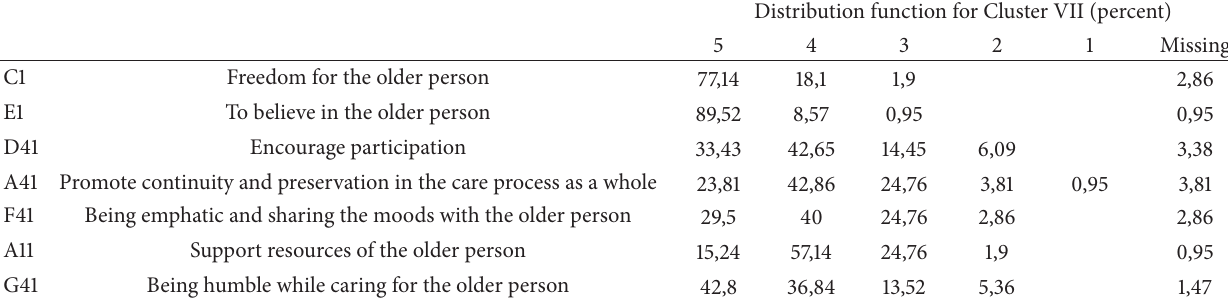
Table 11: Cluster VII: Possibilities for participation.